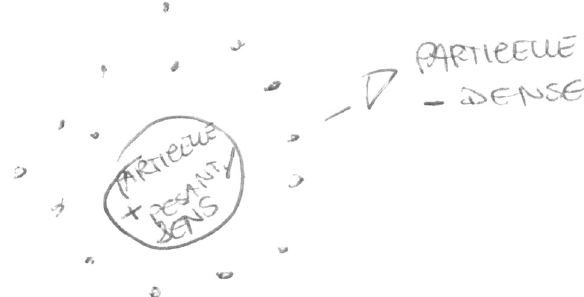
FIG. 9. Sample 2 student ’ s sketch of mass distribution within a star. Translation of Italian labels, from left to right: higher density of particles, lower density of